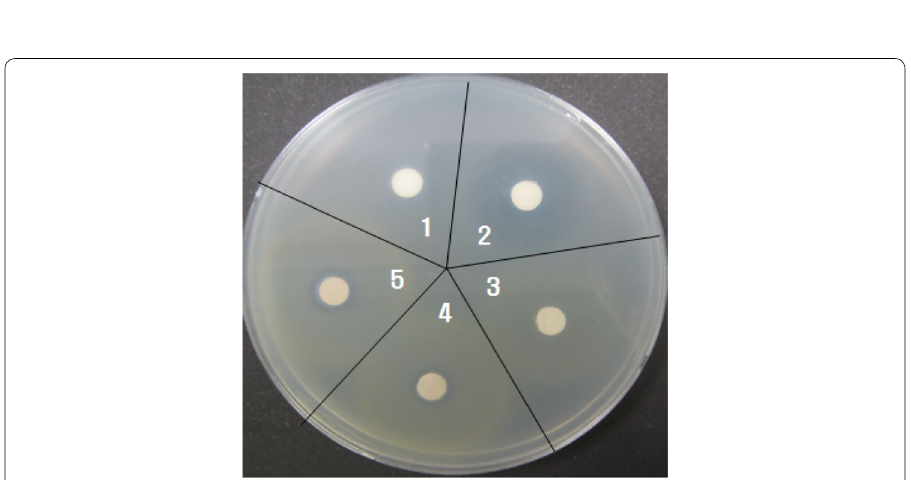
Fig. 2 Antibacterial rates of persimmon peel extract: (1) control (H 2 O), (2) tetracycline 10 μg, (3) 2 mg/disc, (4) 5 mg/disc, (5) 10